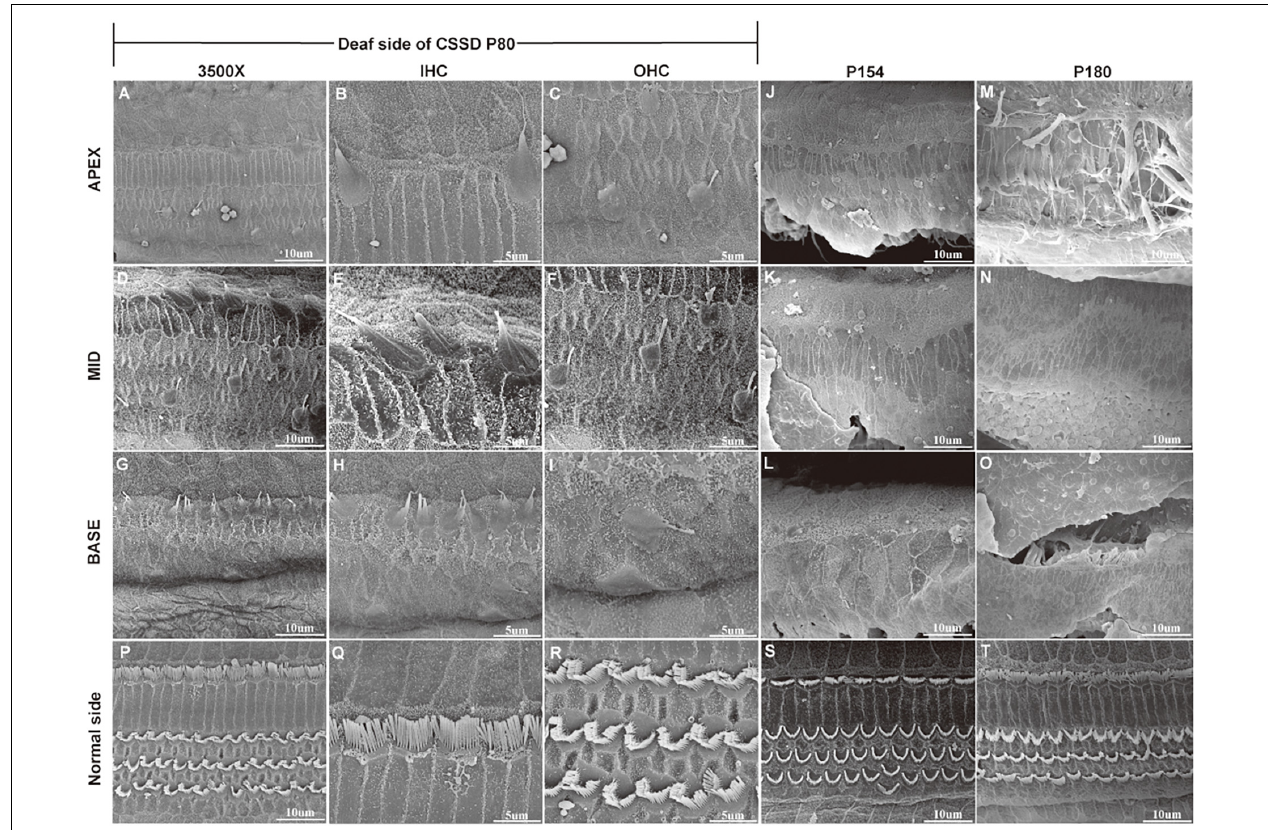
FIGURE 6 | SEM results of the basal membrane of congenital single-sided deafness (CSSD) individual at different ages. (A–I) Images of the basal membrane of the deaf side of CSSD at P80. (A,D,G) Images from the apex to base turn of the cochlear at low magnification of 3,500 × . (B–I) Inner (IHCs) and outer hair cells (OHCs) from the apex to base turn at high magnification of 8,000 × . (J–L) Images of the basal membrane from the apex to base turn of the deaf side of the CSSD at P154; nearly no HCs were left on P154. (M–O) Images of the basal membrane from the apex to base turn of the deaf side of the CSSD at P180. (P–T) Images of the contralateral normal side of the CSSD individuals at P80, P154, and P180,